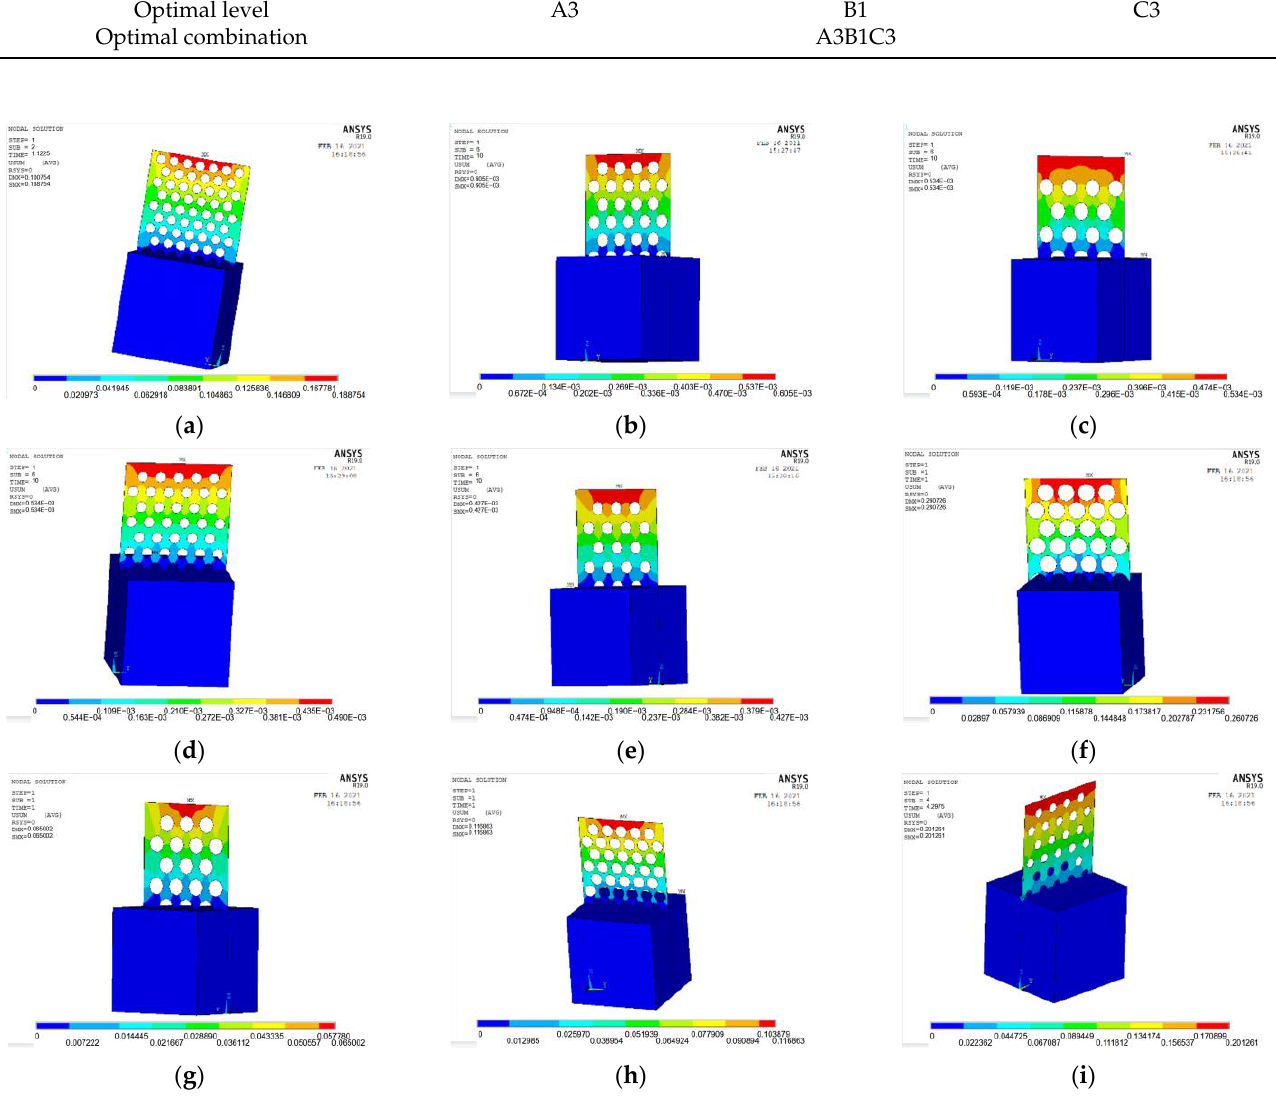
Figure 19. Strain cloud images of nine groups of perforated steel plate reinforced concrete samples: ( a ) test number 1; ( b ) test number 4; ( c ) test number 7; ( d ) test number 2; ( e ) test number 5; ( f ) test number 8; ( g ) test number 3; ( h ) test number 6; ( i ) test number 9.